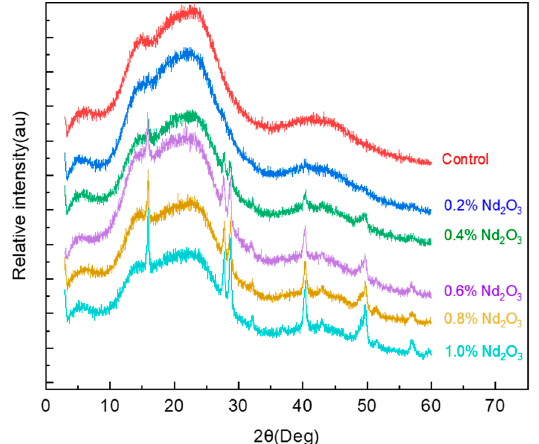
Figure 4. The XRD spectra of the imide oligomers with different Nd 2 O 3 contents. The FTIR and XRD results already demonstrated that Nd 2 O 3 changed to the